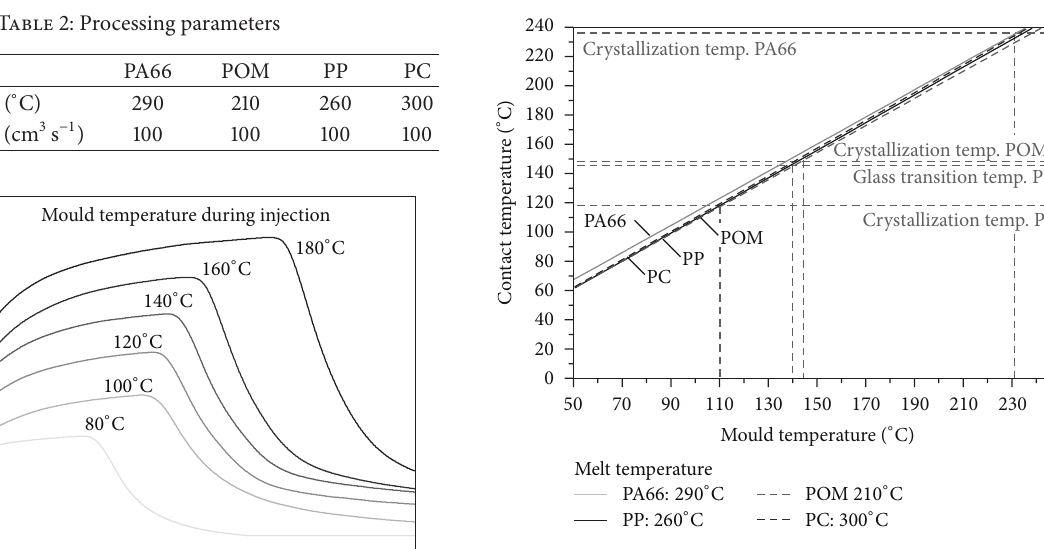
Figure 3: Analytically calculated contact temperature as function of the mould temperature.